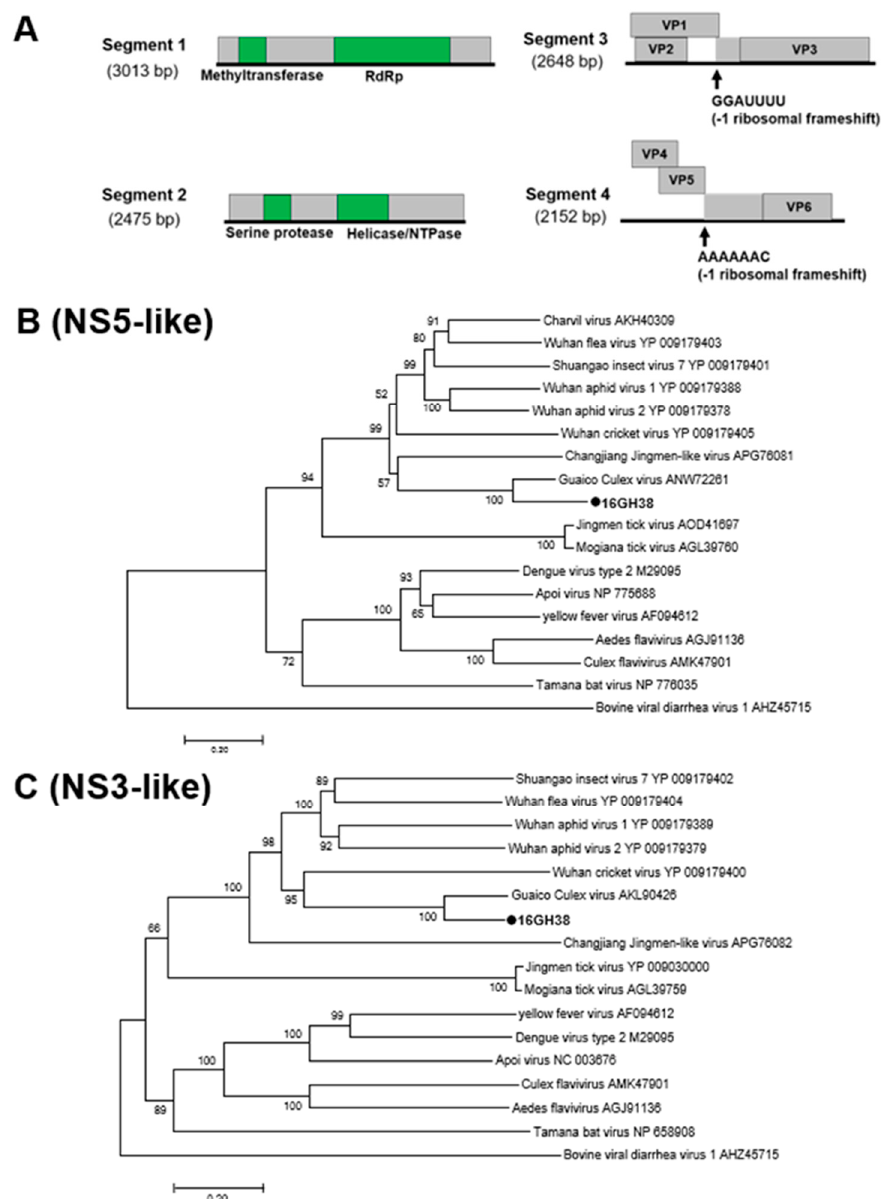
Figure 10. Genetic characterization of Mole Culex virus (MoCV). ( A ) Genome structure of MoCV showing 4 segments and an RFS in segments 3 and 4. ( B ) and ( C ) Phylogenetic analysis using the conserved non-structural (NS) domains. Maximum likelihood trees constructed using the NS3 and NS5 amino acid domains of genome sequences with Genbank accession numbers LC505052 and LC505053, respectively. The amino acid domain was aligned using the MAFFT 7 online version [27]. Bootstrap support values from 1000 bootstrap replicates are indicated on the branches.